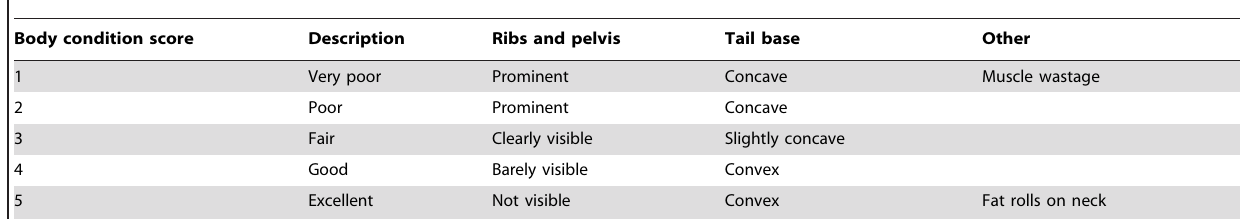
Table 2. Criteria used for determining body condition scores.